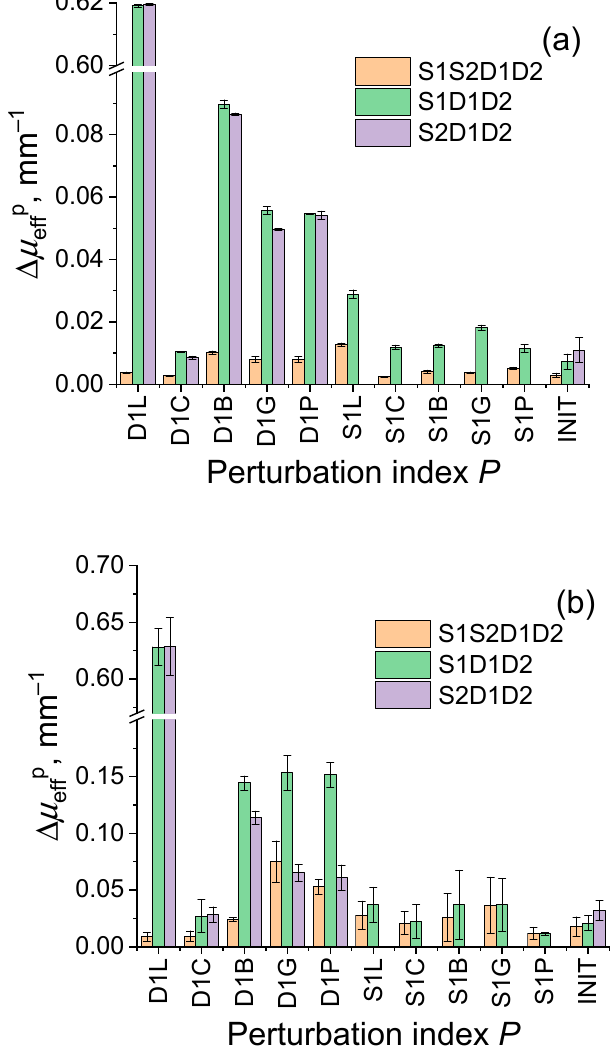
Figure 5. Deviations in extinction coefficient ∆ µ P spectra calculated for different types of per- turbations by Equation (15) using single-slope approach in configurations S1D1D2 and S2D1D2 and self-calibrating approach S1S2D1D2 in phantom ( a ) and in vivo ( b ) studies. Error bars show deviations in ∆ µ P , m values.